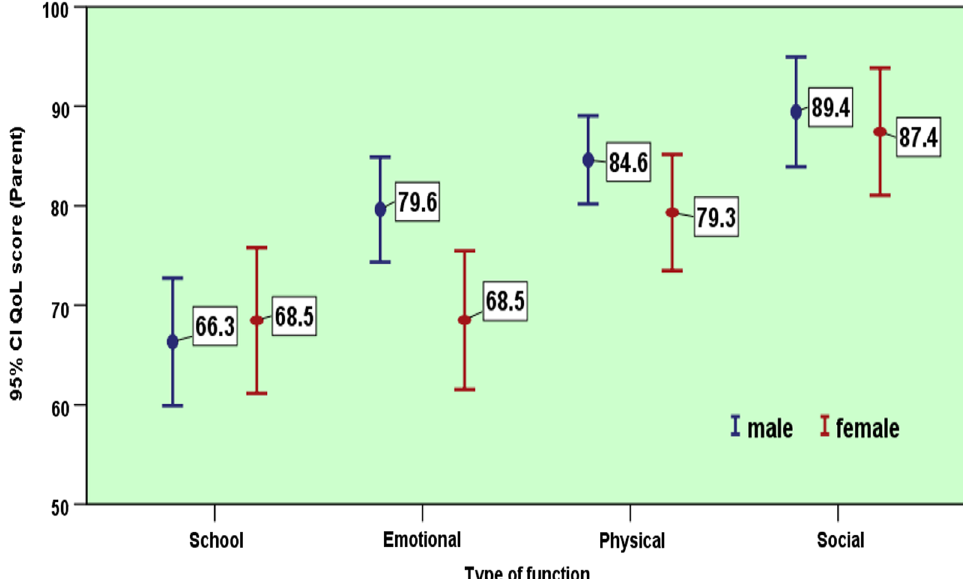
Fig. 5 Parent reported QoL in different components based on